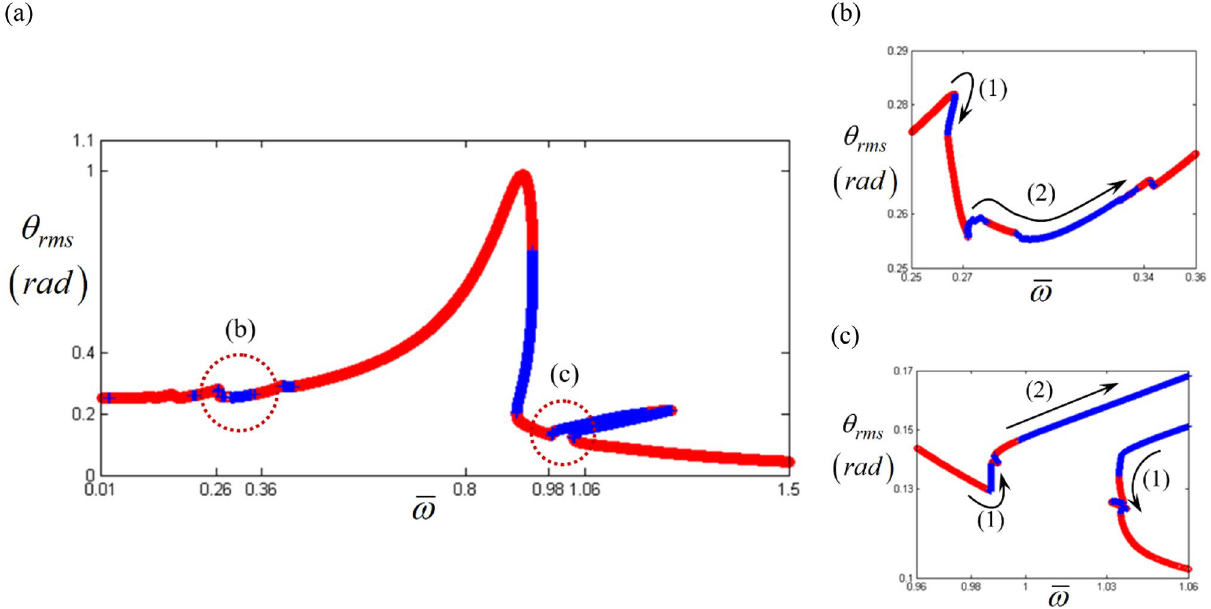
Figure 2. Nonlinear frequency response with RMS reflecting the stability conditions under the frequency upsweeping: ( a ) RMS values with super- and sub-harmonic regimes; ( b ) super-harmonic regimes and their dynamic flows; ( c ) sub-harmonic regimes and their dynamic flows. Key: circle, stable solutions; plus, unstable